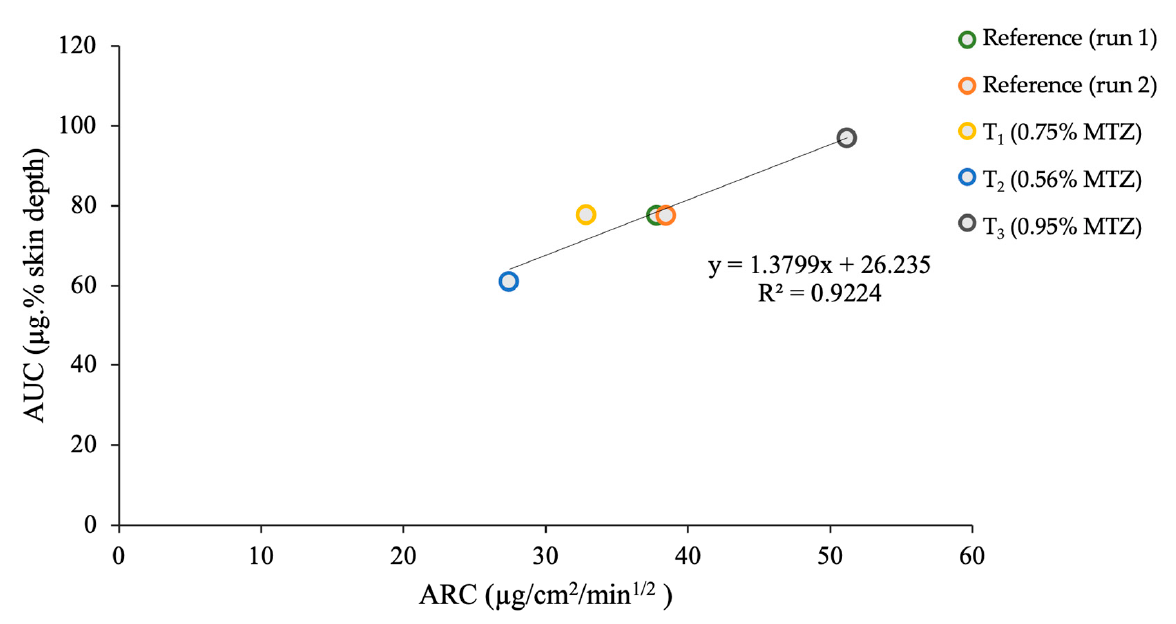
Figure 2. Relationship between the AUC and ARC deduced from the TS study (in vivo) in human participants (n = 10) and IVRT studies (in vitro) (n = 6). Table 1. Predicted AUC values obtained from ARC values.